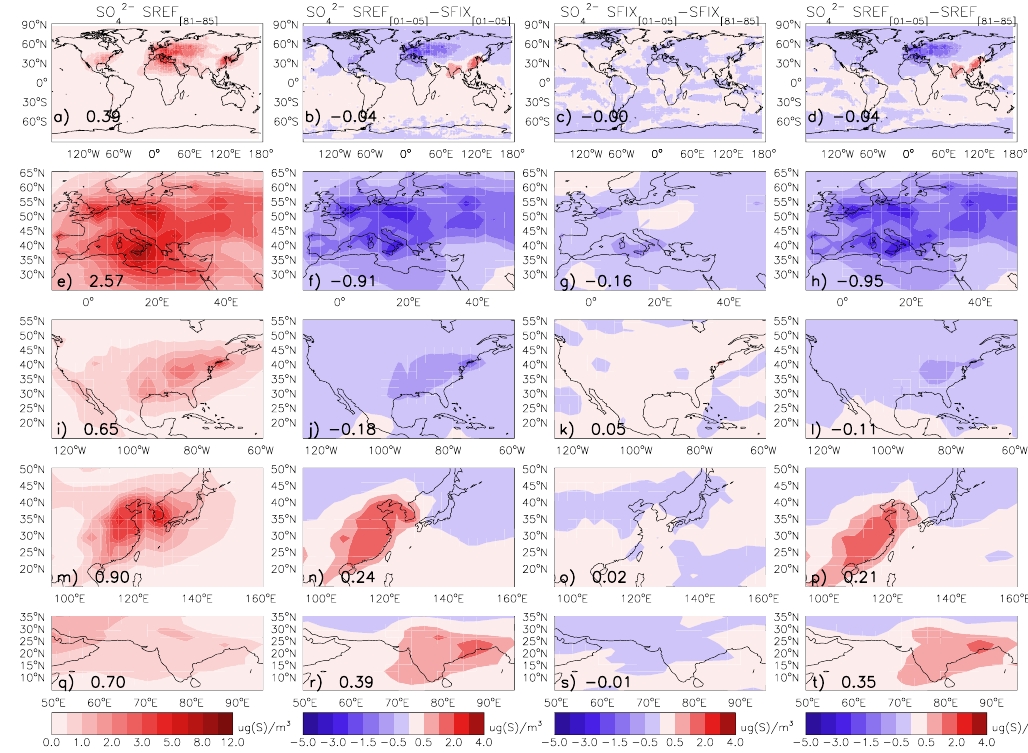
Fig. 10. As Fig. 5 but for SO 2 −